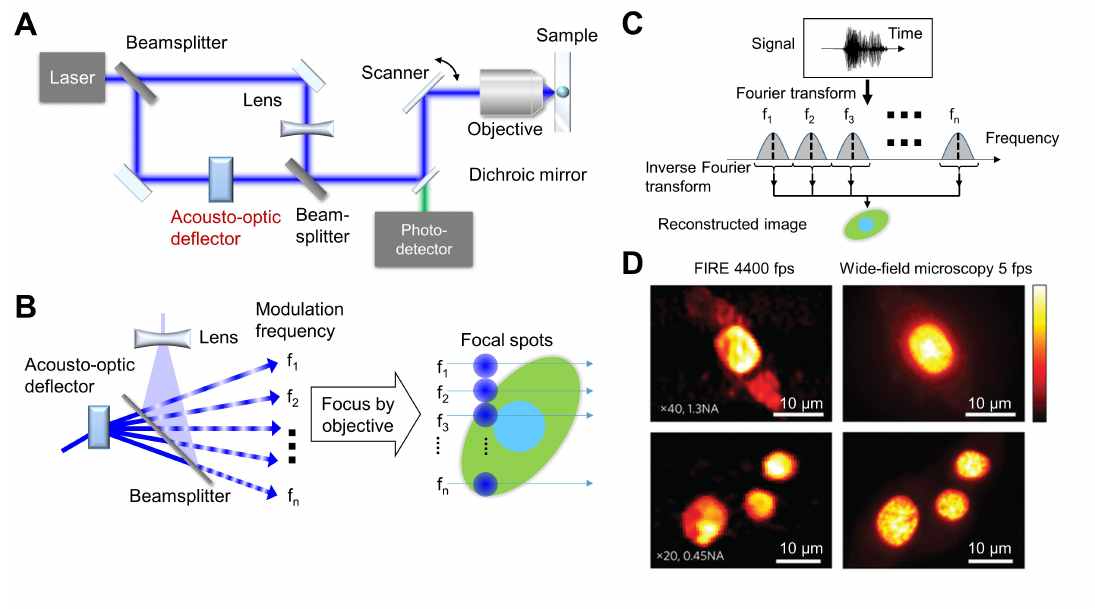
Fig. 7. FIRE. (A) Schematic. (B) Principle of radiofrequency encoding. (C) Principle of the image reconstruction. (D) Fluorescence imaging of cells with FIRE in comparison to conventional wide-field microscopy. ©Figure courtesy of Ref. [9].